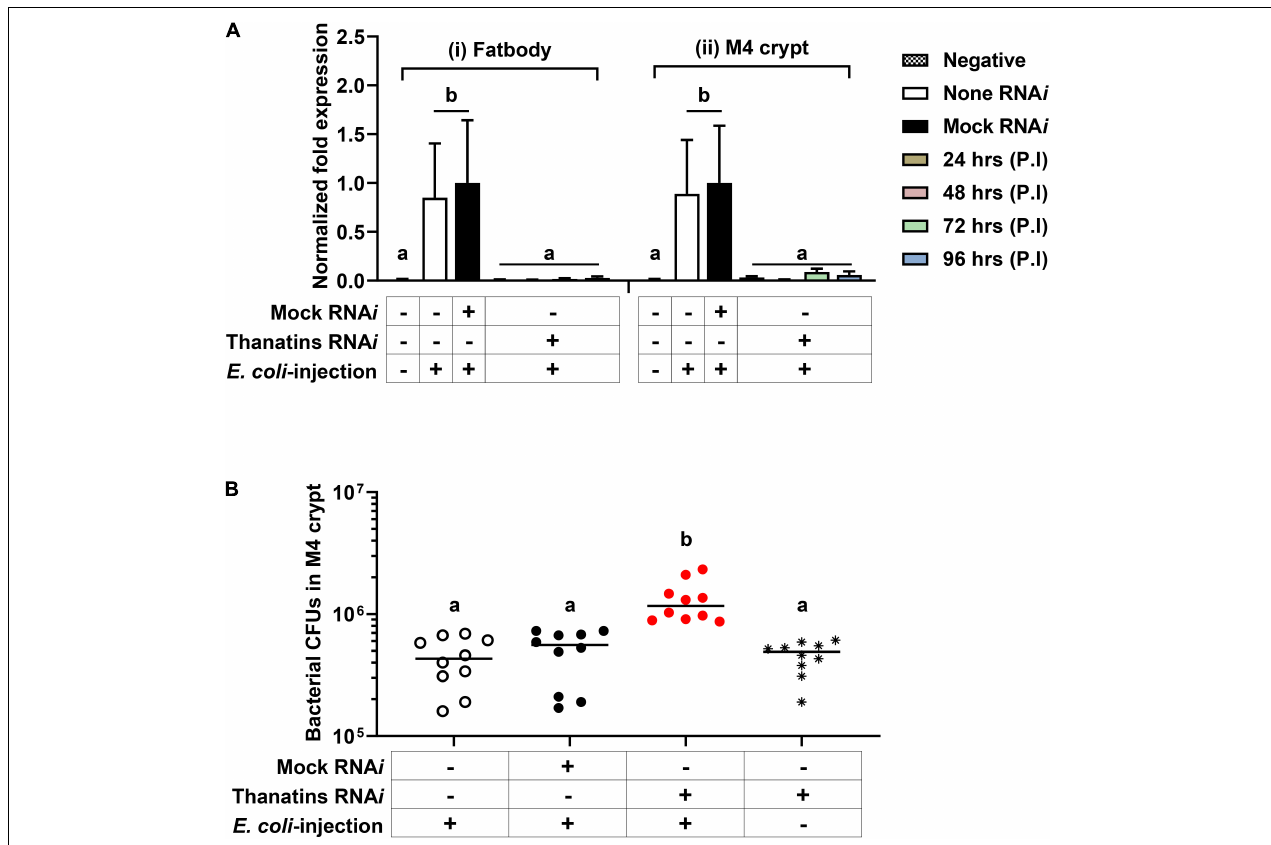
FIGURE 5 | The population of Burkholderia gut symbiont after RNA i of the thanatin isoforms. (A) mRNA expression levels of thanatin genes in (i) the fat body and (ii) M4 crypt after RNA i of the target gene upon systemic E. coli K12 injection. The expression levels of the thanatin genes were normalized to the expression level of each mock-control, which was set as 1. Data are expressed as mean ± SD ( n = 6). Different letters (a and b) on the top of the columns indicate statistically significant differences ( P < 0.05; one-way ANOVA with Tukey’s correction). (B) The population of M4 crypt-colonized Burkholderia cells in the thanatin genes silenced R. pedestris upon systemic E. coli K12 injection. Data are expressed as mean ± SD ( n = 10). Different letters (a and b) on the top of the columns indicate statistically significant differences ( P < 0.05; one-way ANOVA with Tukey’s correction). The CFUs in M4 crypts were measured on 4 days after dsRNA injection or 3 days after E. coli K12 cells